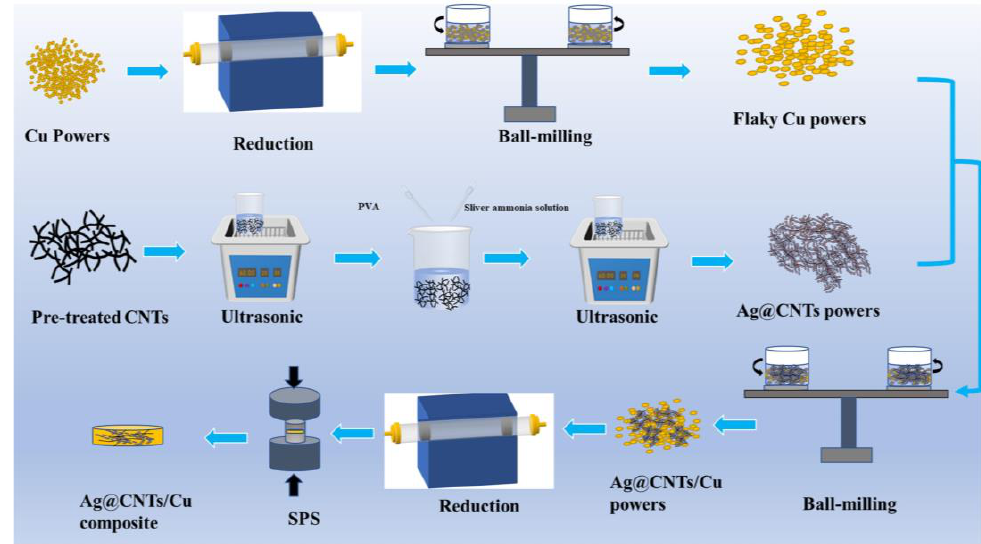
Figure 1. Diagram of the preparation process of Ag-CNTs/Cu composites.